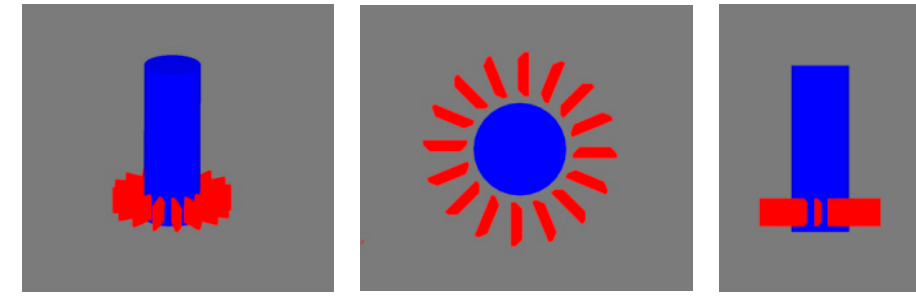
Figure 12. Layout of the hybrid mono-pile.